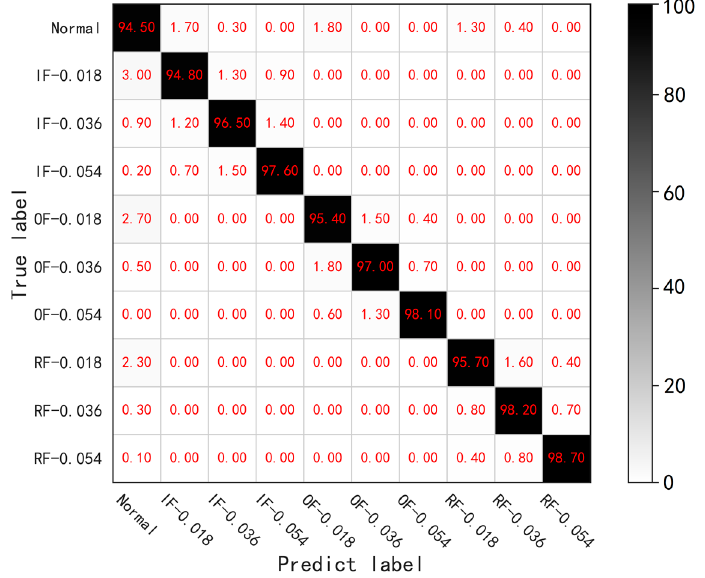
Figure 10. The confusion matrix of the diagnosis result in the condition of SNR= –2 dB.